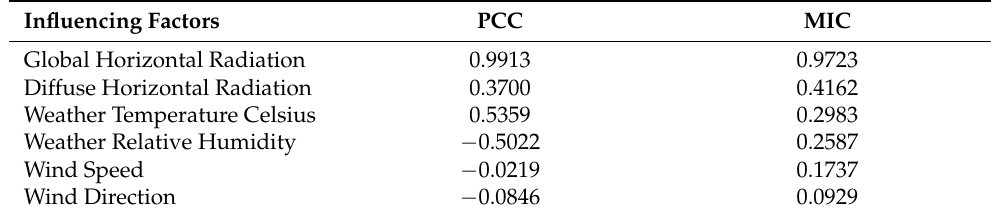
Table 1. Results of the PCC and MIC.